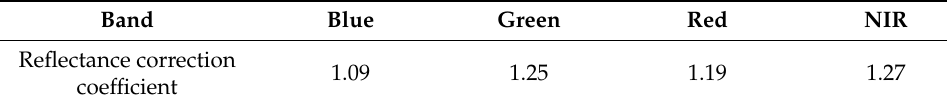
Table 9. Reflectance correction coefficient of the Landsat-8 satellite image. Band Blue Green Red NIR Reflectance correction coefficient